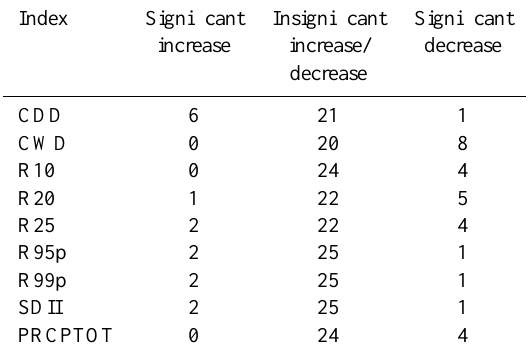
Table 3. Number of stations with significant increasing (0.1 of sig- nificance level) for annual extreme temperature indices during the period of